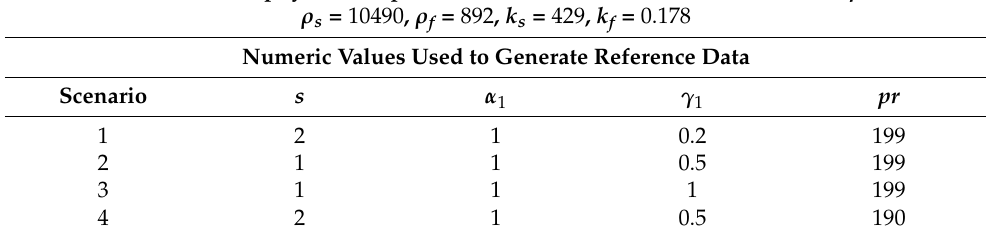
Table 1. Scenarios for heat transmission in spinning nanofluid in rotating system. Nanofluid Thermophysical Properties Utilized to Generate Reference Data, 𝝋 = 𝟎. 𝟎𝟏 𝝆 = 𝟏𝟎𝟒𝟗𝟎, 𝝆 = 𝟖𝟗𝟐, 𝒌 = 𝟒𝟐𝟗, 𝒌 = 𝟎. 𝟏𝟕𝟖